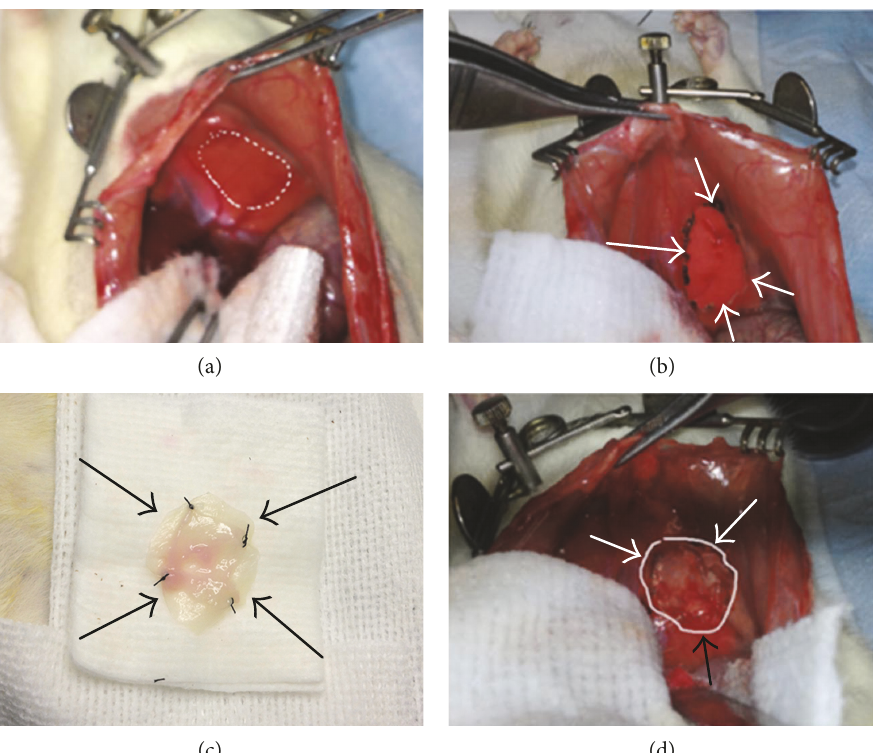
Figure 2: The surgical procedure to create the diaphragmatic defect and repair. (a) The rat diaphragm is explored through an abdominal approach, and the surgical defect is created. (b) A standardized defect size of 1.2 × 1.2cm in the left side of the diaphragm is